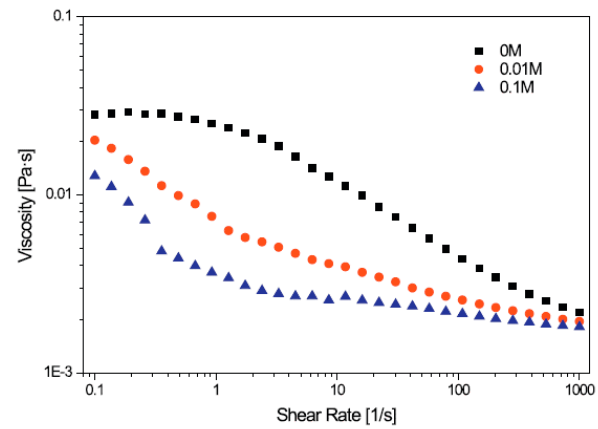
Figure 4. Shear viscosity as a function of various concentrations of KCl at 200 ppm, reprinted with permission from [65]. Copyright Elsevier Ltd., 2015.